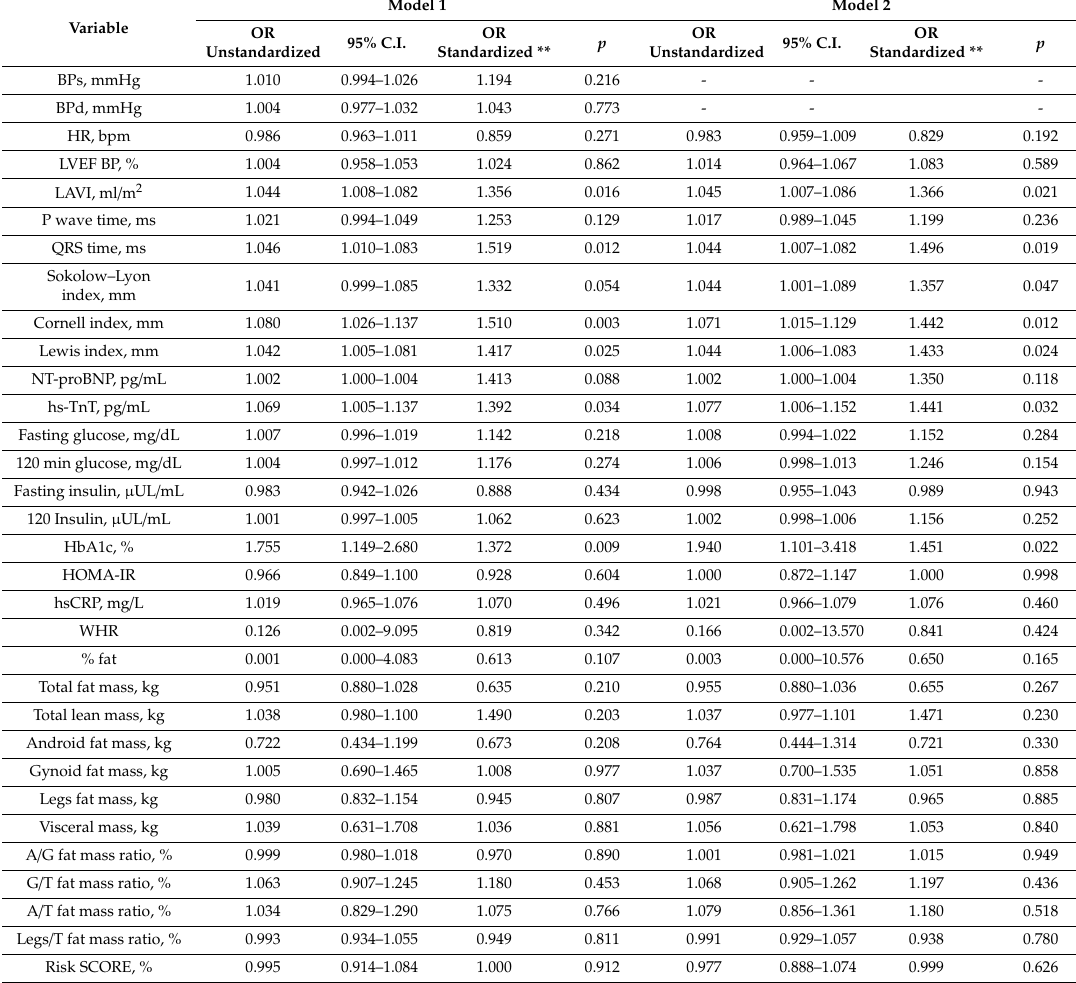
Table 4. Results of the left ventricular hypertrophy * multivariable logistic regression analysis in the study